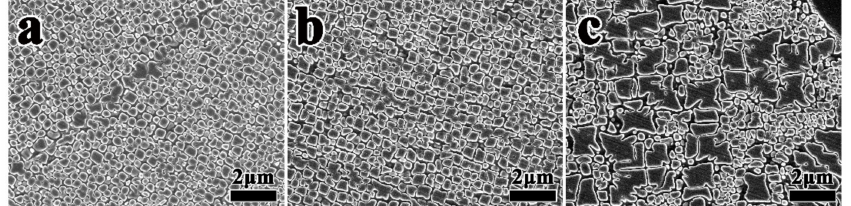
Figure 7. Typical γ ’ phase of GH4975 alloy after heat treatment with various cooling conditions: ( a ) AC, cubic γ ’ phase; ( b , c ) FC, cubic and dendritic γ ’ phase,